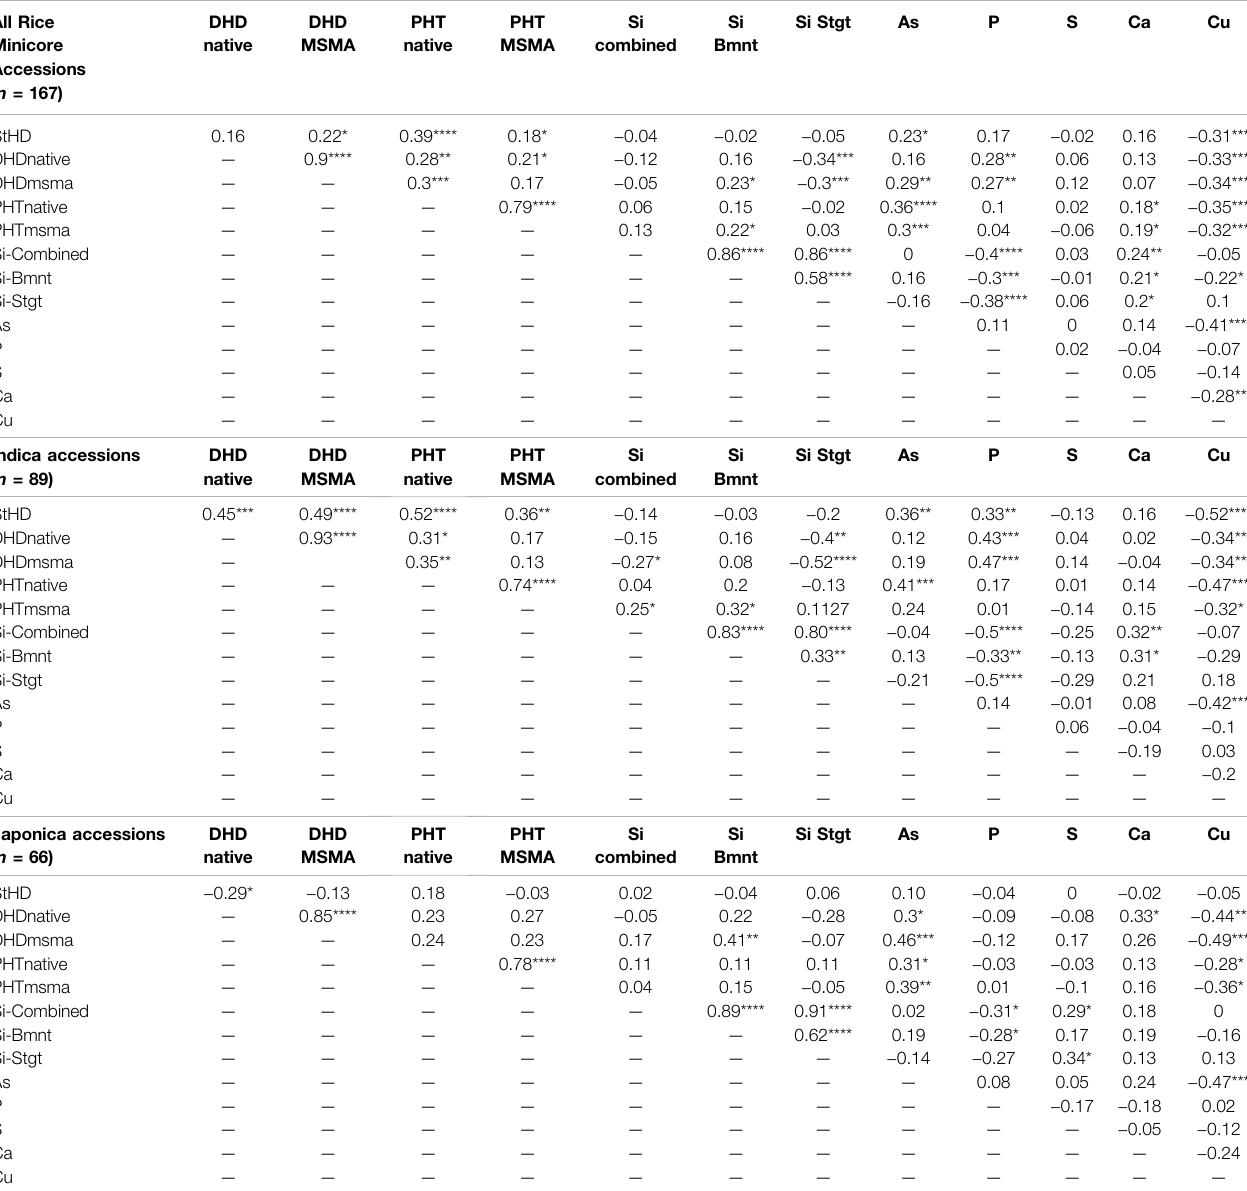
Asterisks indicate signi fi cance at α = 0.05 *, α = 0.01 **, α = 0.001 ***, α = 0.0001 ****. All trait data were from rice grown in fl ooded fi eld plots to maximize arsenic uptake and straighthead severity. Straighthead (StHD), days to heading (DHDmsma), and plant height (PHTmsma) were evaluated in 2015 and 2016 in Stuttgart, Arkansas, United States, using plots in MSMA-treated fi eld area. DHDnative and PHTnative were evaluated the same year in the Stuttgart, Arkansas fi eld area with “ native soil ” (not treated with MSMA); silica (Si) concentrations were evaluated using hulls from rice harvested 2 replications × 1 year from both Beaumont, Texas, and Stuttgart, Arkansas; concentrations of arsenic (As), phosphorus (P), sulfur (S), calcium (Ca), and copper (Cu), and -Cu were measured in grains harvested 2 replications × 2 years in Beaumont,